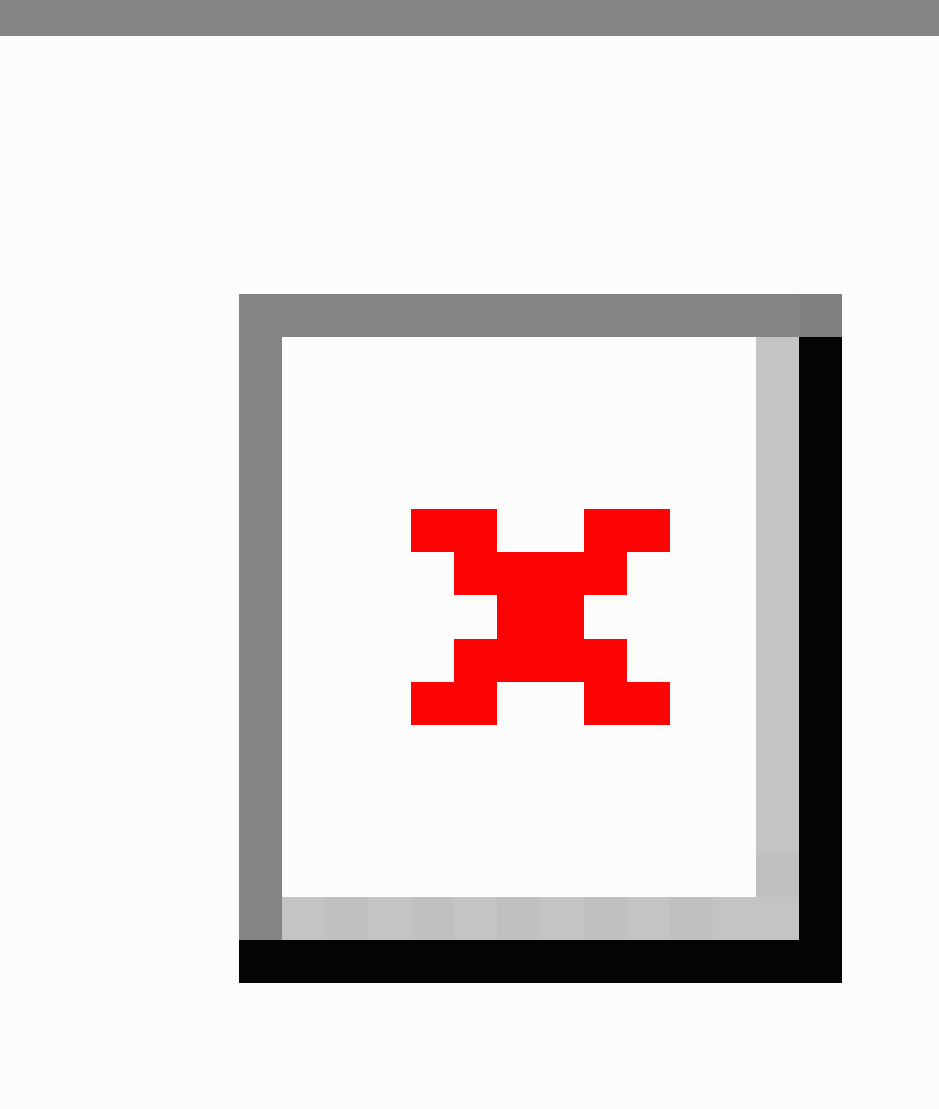
Interaction Effect of Portal Access and Baseline PAM Level on Change in PAM Score No statistically significant interaction effect on change in patient activation was detected between portal access and baseline PAM level ( F =0.62, P =.54, η 2 =0.009). Figure 4 presents the linear 2,137